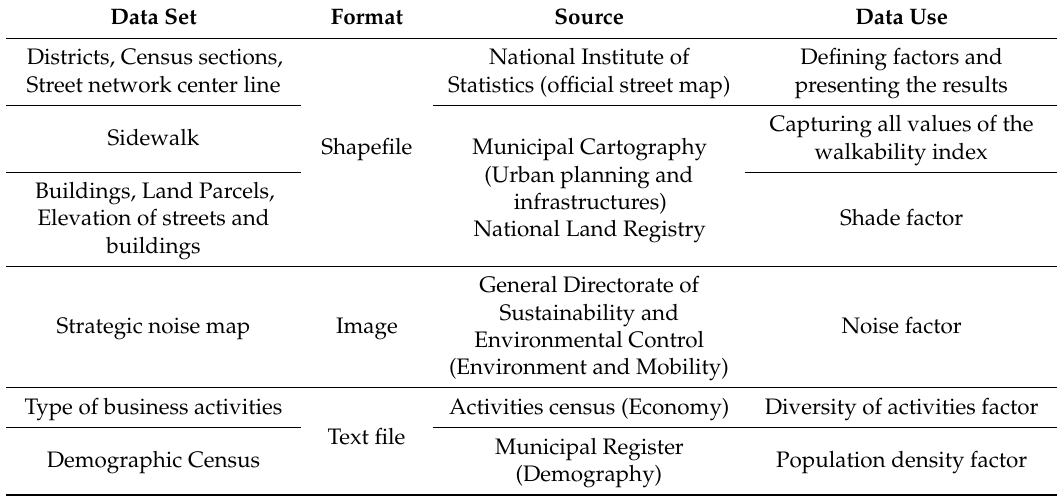
Table 2. Collected